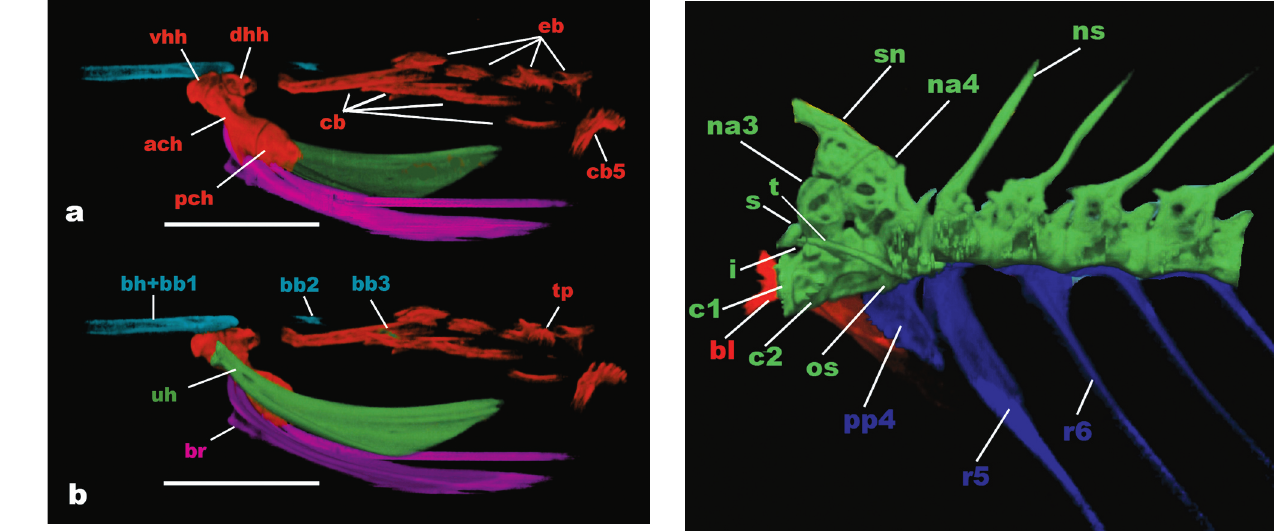
Fig. 7. Branchial basket and branchiostegals rays of left side of Iracema caiana (MZUSP 49205, 235 mm SL). ( a ) Lateral view; ( b ) Midsagittal view. Anterior to left. Scale bar is 5 mm. Abbreviations: bh+bb1 = basihyal +basibranchial 1; bb2 = basibranchial 2; bb3 = basibranchial 3; vhh = ventral pch = posterior ceratohyal; uh = urohyal; br = branchiostegals; cb = ceratobranchial; eb = epibranchial; and tp = pharyngobranchial tooth plate.